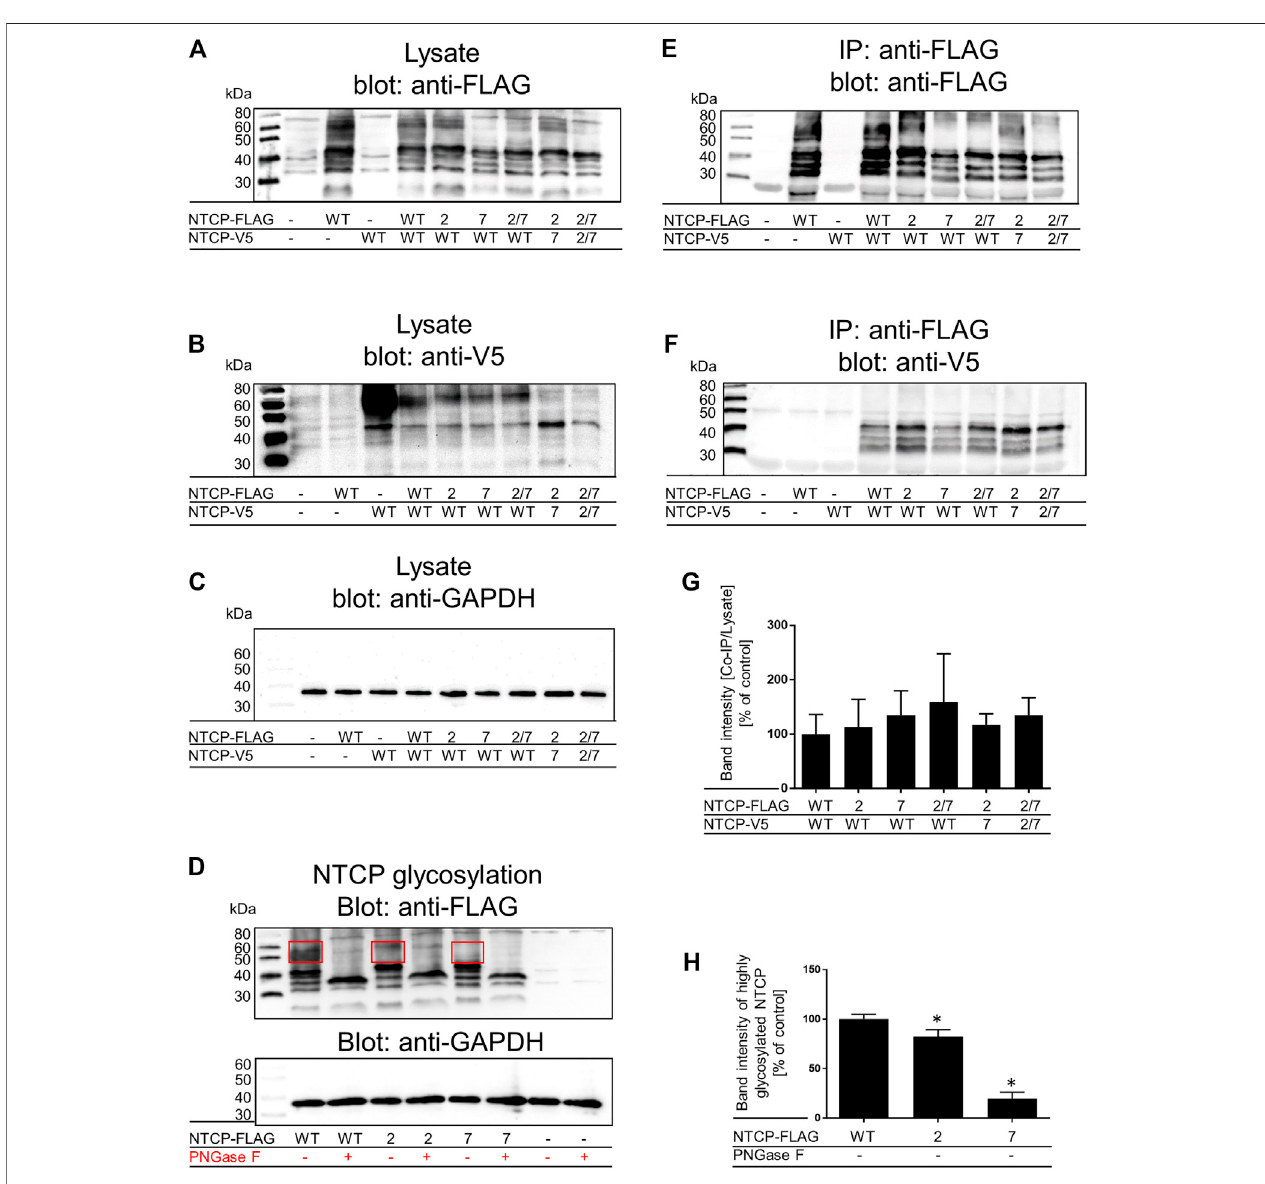
FIGURE 3 | Co-IP and glycosylation status of wild-type and mutant NTCPs. Wild-type and mutant NTCP-V5-His and NTCP-FLAG constructs were mono- transfected or co-transfected into HEK293 cells as indicated. Cell lysates were analyzed by western blotting with (A) an anti-FLAG antibody, (B) an anti-V5 antibody or (C) and anti-GAPDH antibody. Cell lysates from un-transfected cells were used as negative control, mono-transfected cells served as positive controls. In the fi gure legendtheNTCPTMD2,TMD7andTMD2/7mutantsarebrie fl yindicatedas “ 2 ” , “ 7 ” and “ 2/7 ” ,respectively.ThesecelllysateswerealsousedforIPwithanti-FLAG agarose and then were processed for western blotting with (E) an anti-FLAG antibody or (F) an anti-V5 antibody. (G) Band intensities of three independent co-IP experiments were measured using ImageJ and signal intensities from the IP anti-V5 signals were normalized for the lysate anti-FLAG signals. Ratios were related to the NTCP(WT)-NTCP(WT)interaction,whichwassetto100%.Datarepresentmeans ± SDofthreeindependentexperiments, oneofwhichisrepresentativelyshownunder (A – C) , and (E, F) . (D) Cell lysates of wild-type and mutant NTCP-FLAG mono-transfected HEK293 cells were subjected to deglycosylation with PNGaseF.